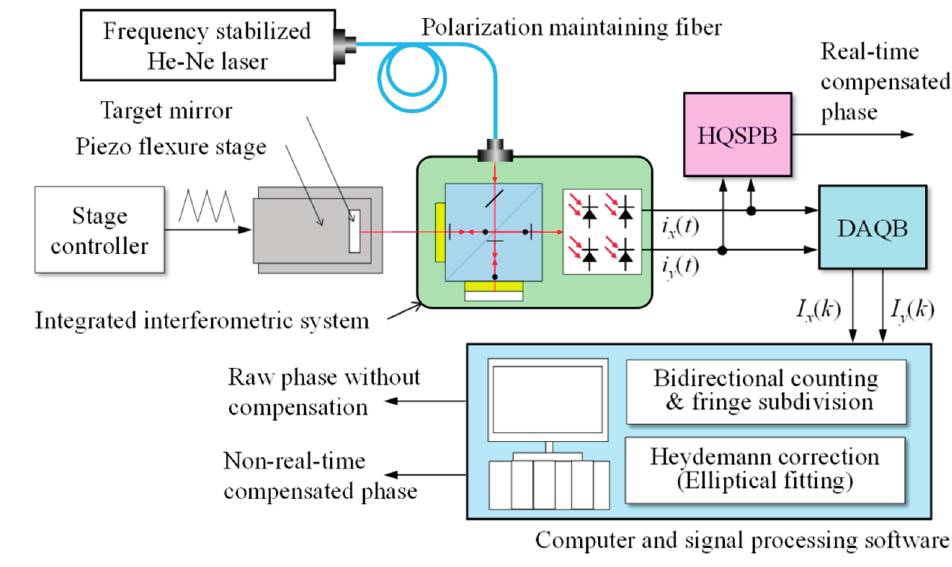
Figure 11. Schematic diagram of the experimental setup: HQSPB (Homemade Quadrature Signal Processing Board) and DAQB (Data Acquisition